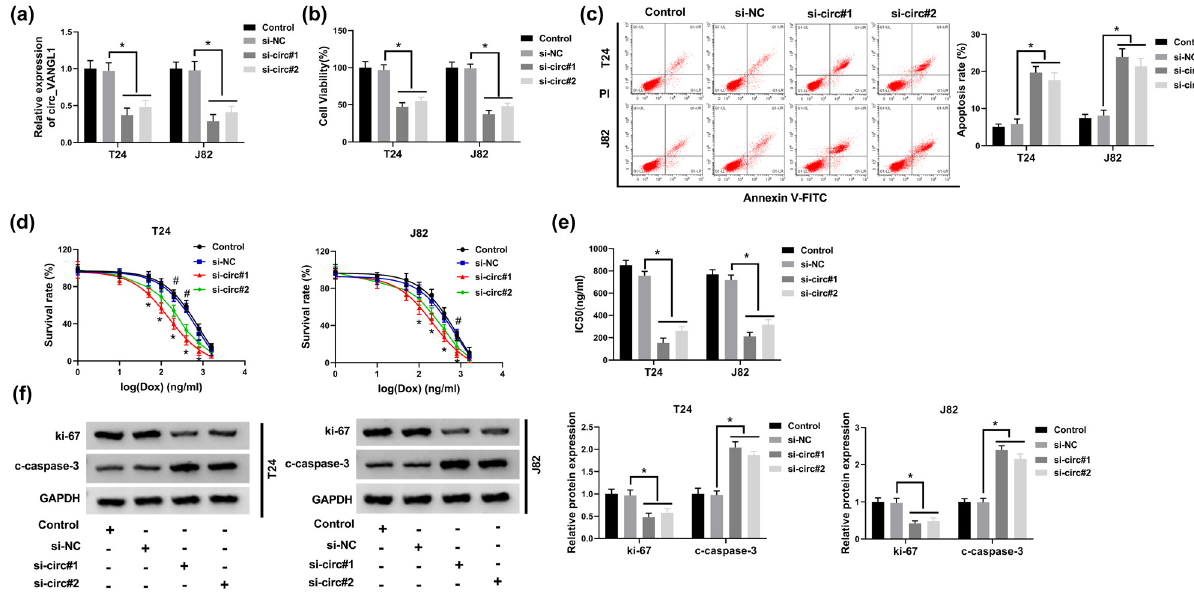
Figure 2: The e ff ect of circ_VANGL1 knockdown on cell viability, apoptosis, and doxorubicin resistance. ( a – f ) T24 and J82 cells were transfected with si - NC, si - circ#1, or si - circ#2, respectively. ( a ) The expression level of circ_VANGL1 in transfected T24 and J82 cells. ( b ) Cell viability was measured by CCK - 8 assay. ( c ) Flow cytometry analysis was performed to assess cell apoptosis rate. ( d ) Di ff erent concen - trations of doxorubicin were incubated with the transfected cells, and then cell apoptosis rate was determined by fl ow cytometry analysis. ( e ) IC ( f ) The protein levels of c - caspase - 3 and ki - 67 in T24 and J82 50 values of the growth of T24 and J82 cells treated with doxorubicin. cells. * P < 0.05, # P < 0.05.